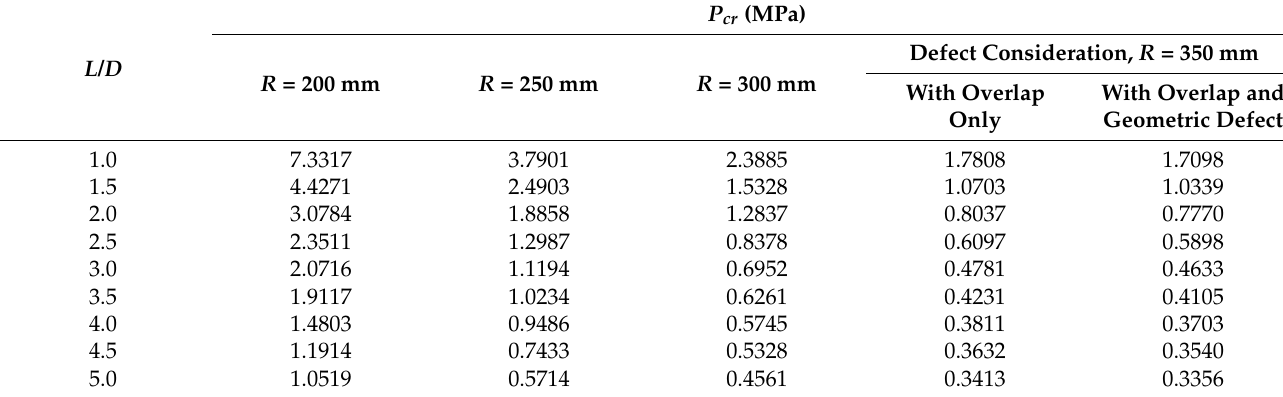
Table 2. Critical buckling pressure obtained from surrogate model, T 0 = 60 ◦ and T 1 = 30 ◦ . L/D